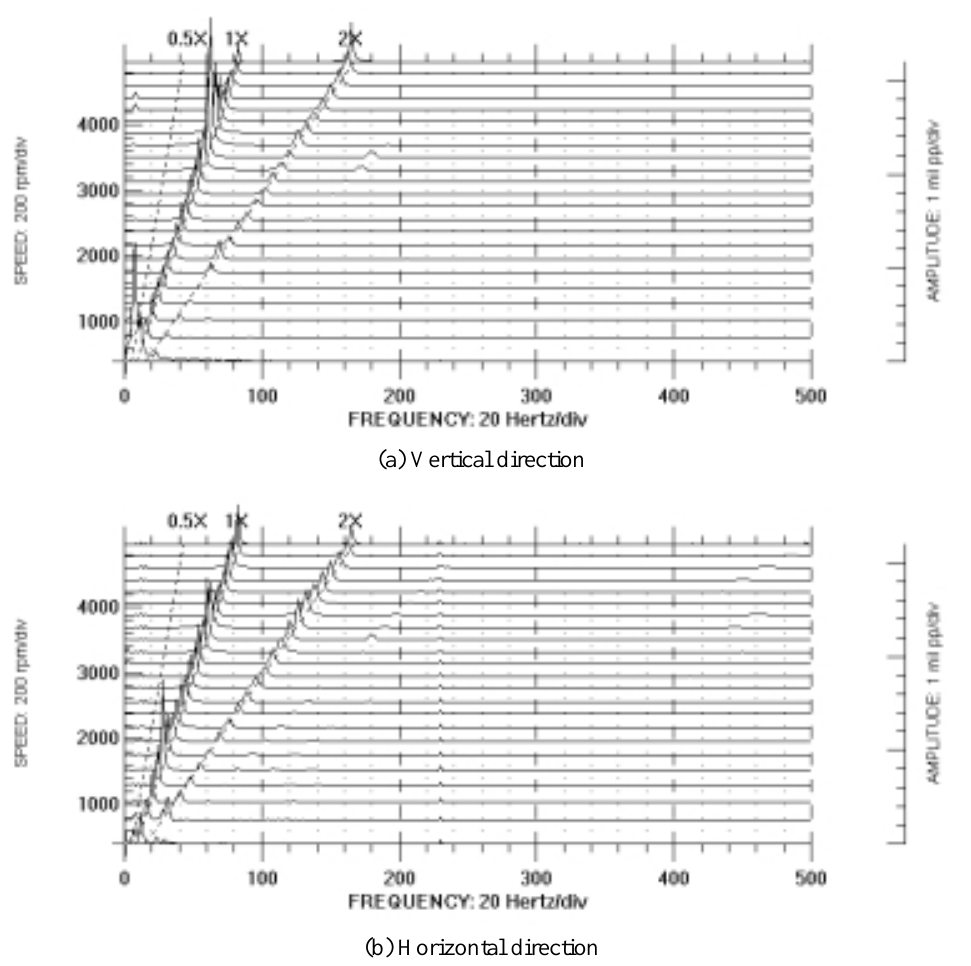
Fig. 11. Frequency cascades of startup data for the 2nd shaft with 4 mm notch crack and 8 kg vertical hanging side